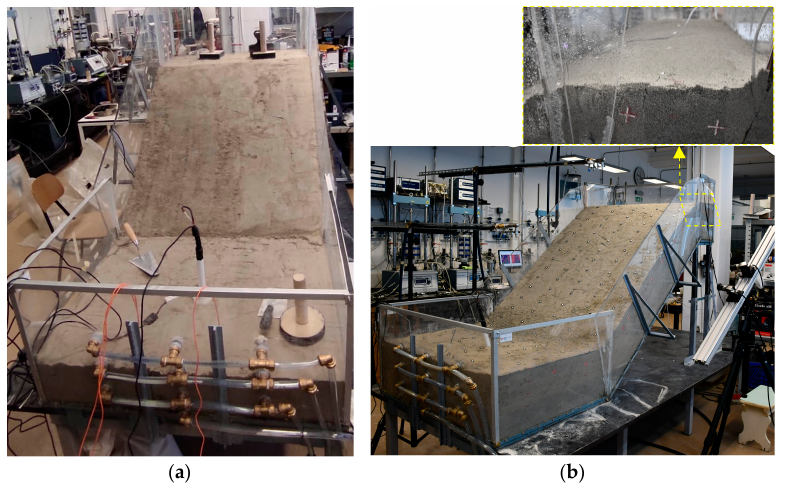
Figure 1. Some details of the model build-up: ( a ) compaction of the soil material with simultaneous installation of the measuring sensors; ( b ) scaled slope model with installed measuring equipment before the start of the test. Table 1. Basic soil properties of clean sand (S) and sand with 10% (SK10) and 15% (SK15) kaolin by mass at the target initial conditions.